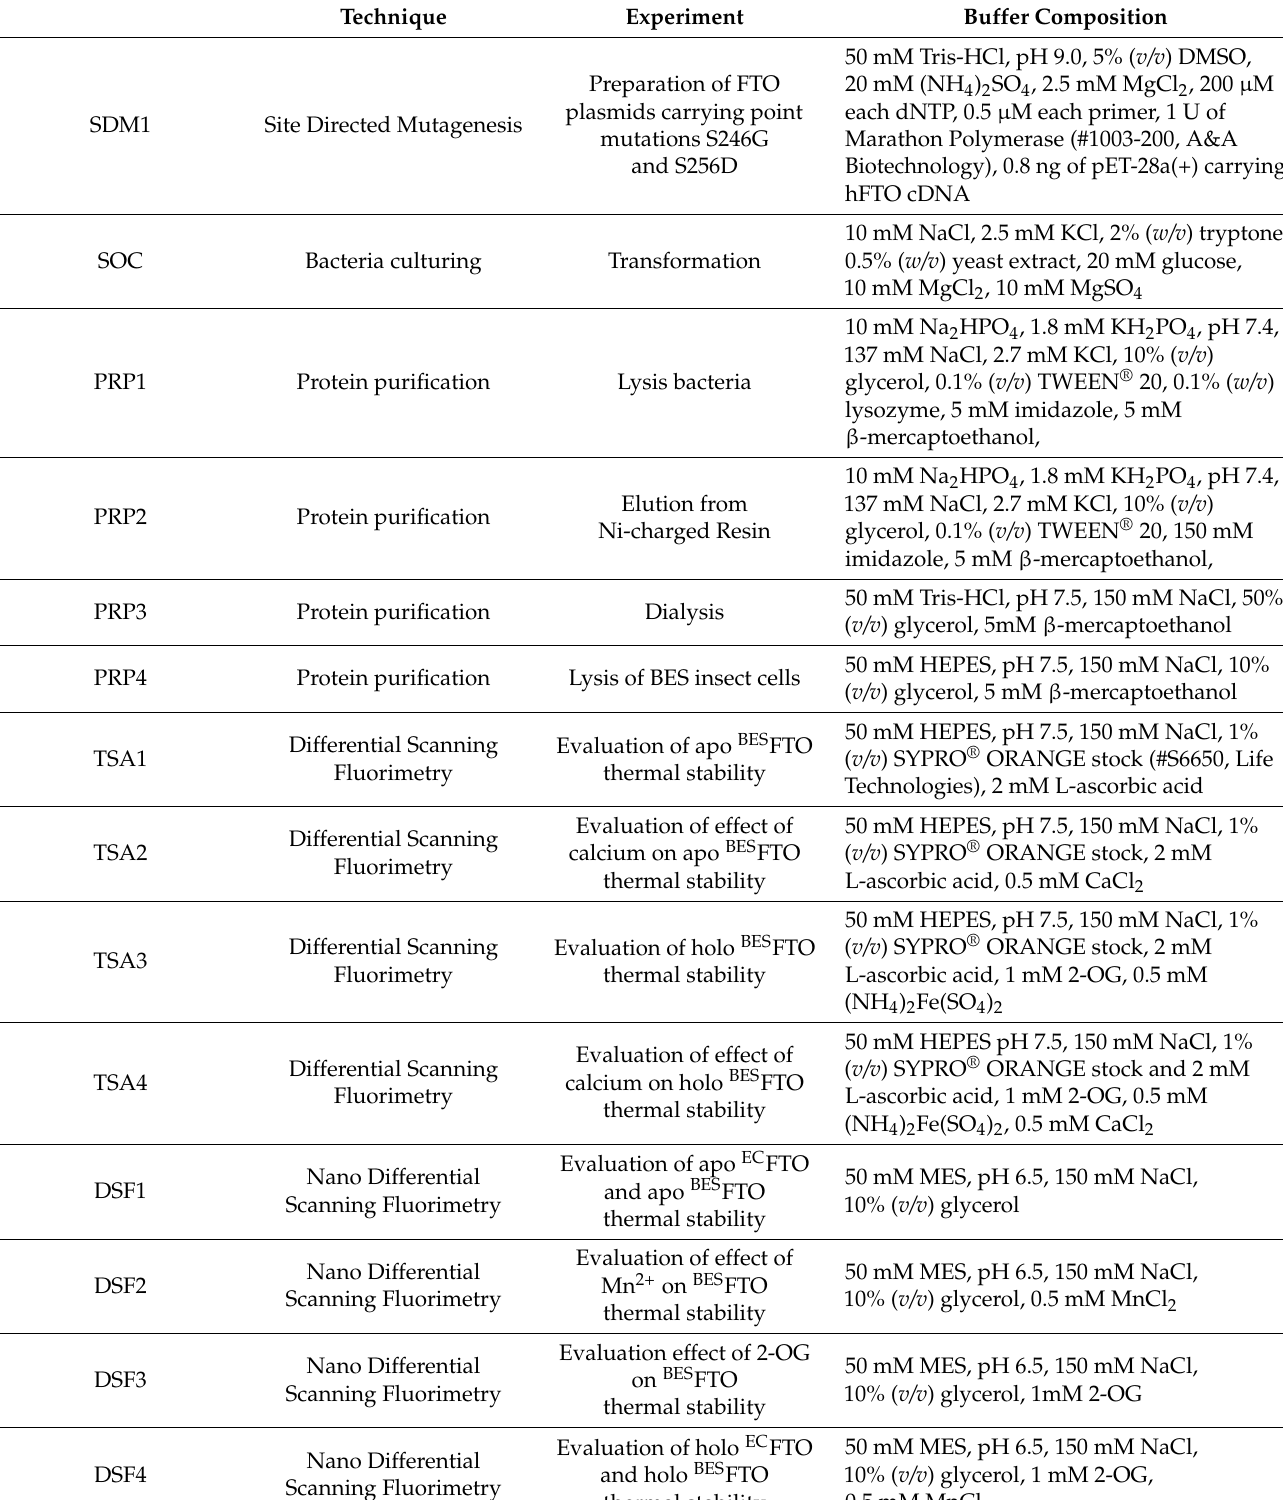
Table 1. Compositions of